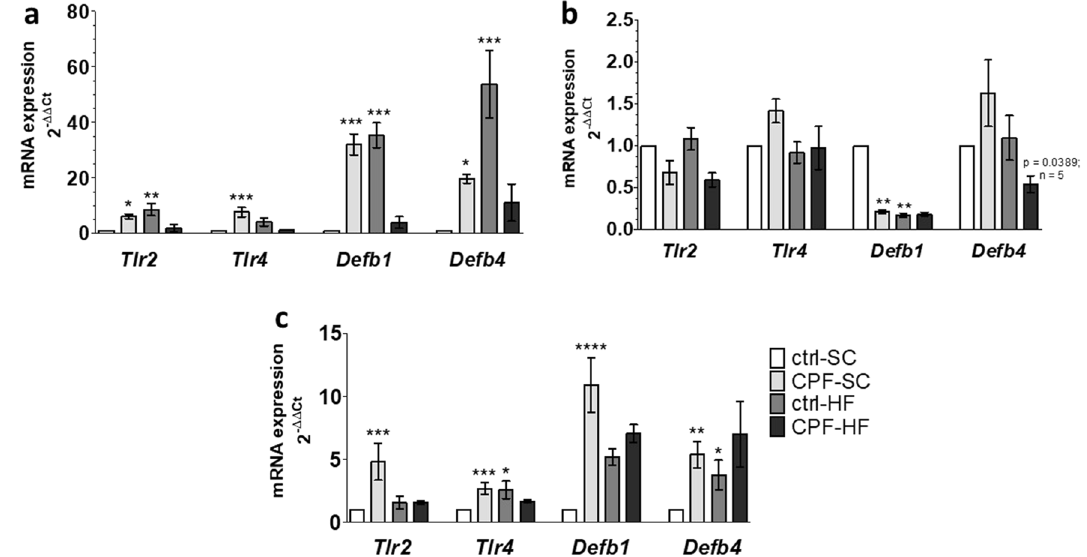
Figure 6. mRNA expression of genes coding for Tlrs and Β Defensins by RT-PCR in male offspring at young adult age from CPF and/or HFD exposed mothers. The mRNA levels of gene expression in ( a ) jejunum, ( b ) ileum, ( c ) proximal colon are expressed as fold induction over the control group set at 1. Values are expressed as mean ± SEM (n = 5–20) using the 2 −ΔΔCt calculation method with the housekeeping gene Gapdh for jejunum and ileum, and Hprt1 for proximal colon segments . * , ** , *** , ****Significantly different (p < 0.05, p < 0.01; p < 0.001; p < 0.0001) from ctrl-SC using the analysis of variance (ANOVA) and a subsequent post hoc Bonferroni test. ctrl control, CPF Chlorpyrifos, HF high fat, SC standard chow, Defb1 Defensin β1, Defb4 Defensin β4, Tlr2 Toll Like Receptor 2, Tlr4 Toll Like Receptor 4.